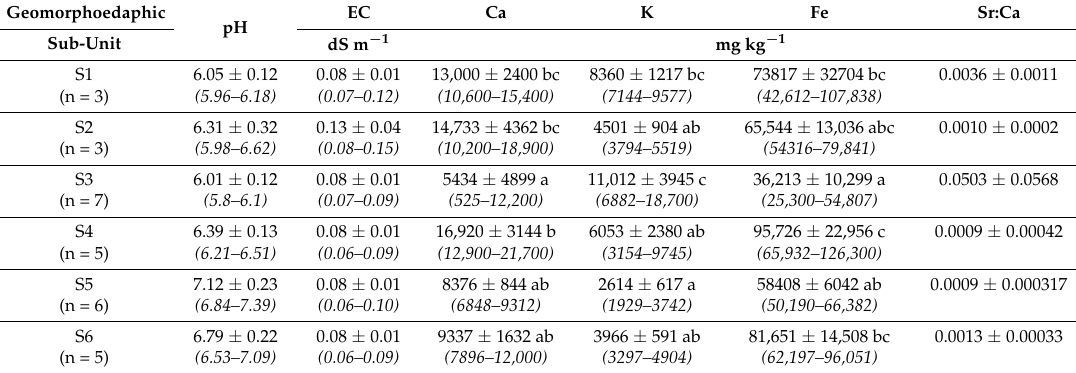
Table 2. Mean values for pH, electric conductivity, concentration of major elements (Ca, K, Fe), and ratio Sr:Ca for the six sampling sub-units (S1–S6) ± STD and minimum and maximum values (min-max). Letters on the right of numbers mean significant differences between samples (Tukey, p <